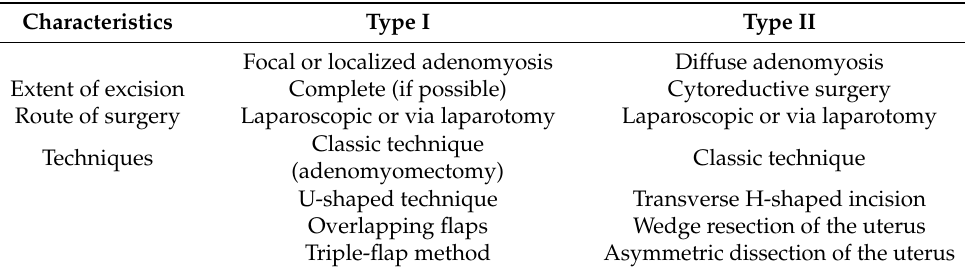
Table 4. Surgical techniques for focal and diffuse